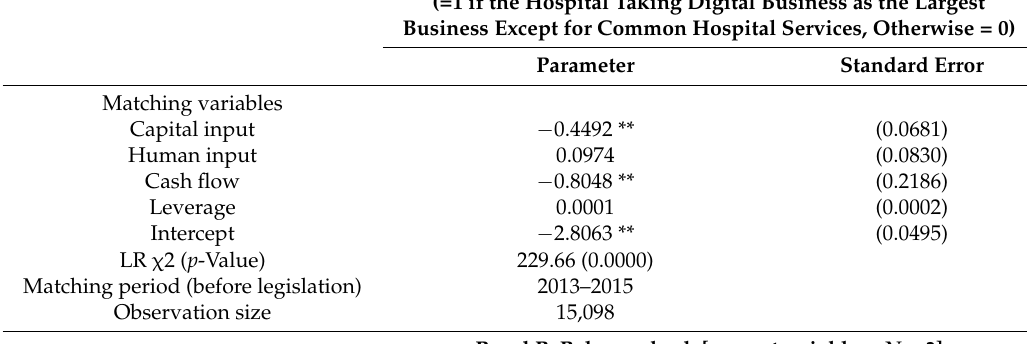
Table A2. The matching quality of propensity score matching (PSM). Panel A. Propensity Score Prediction-Dependent